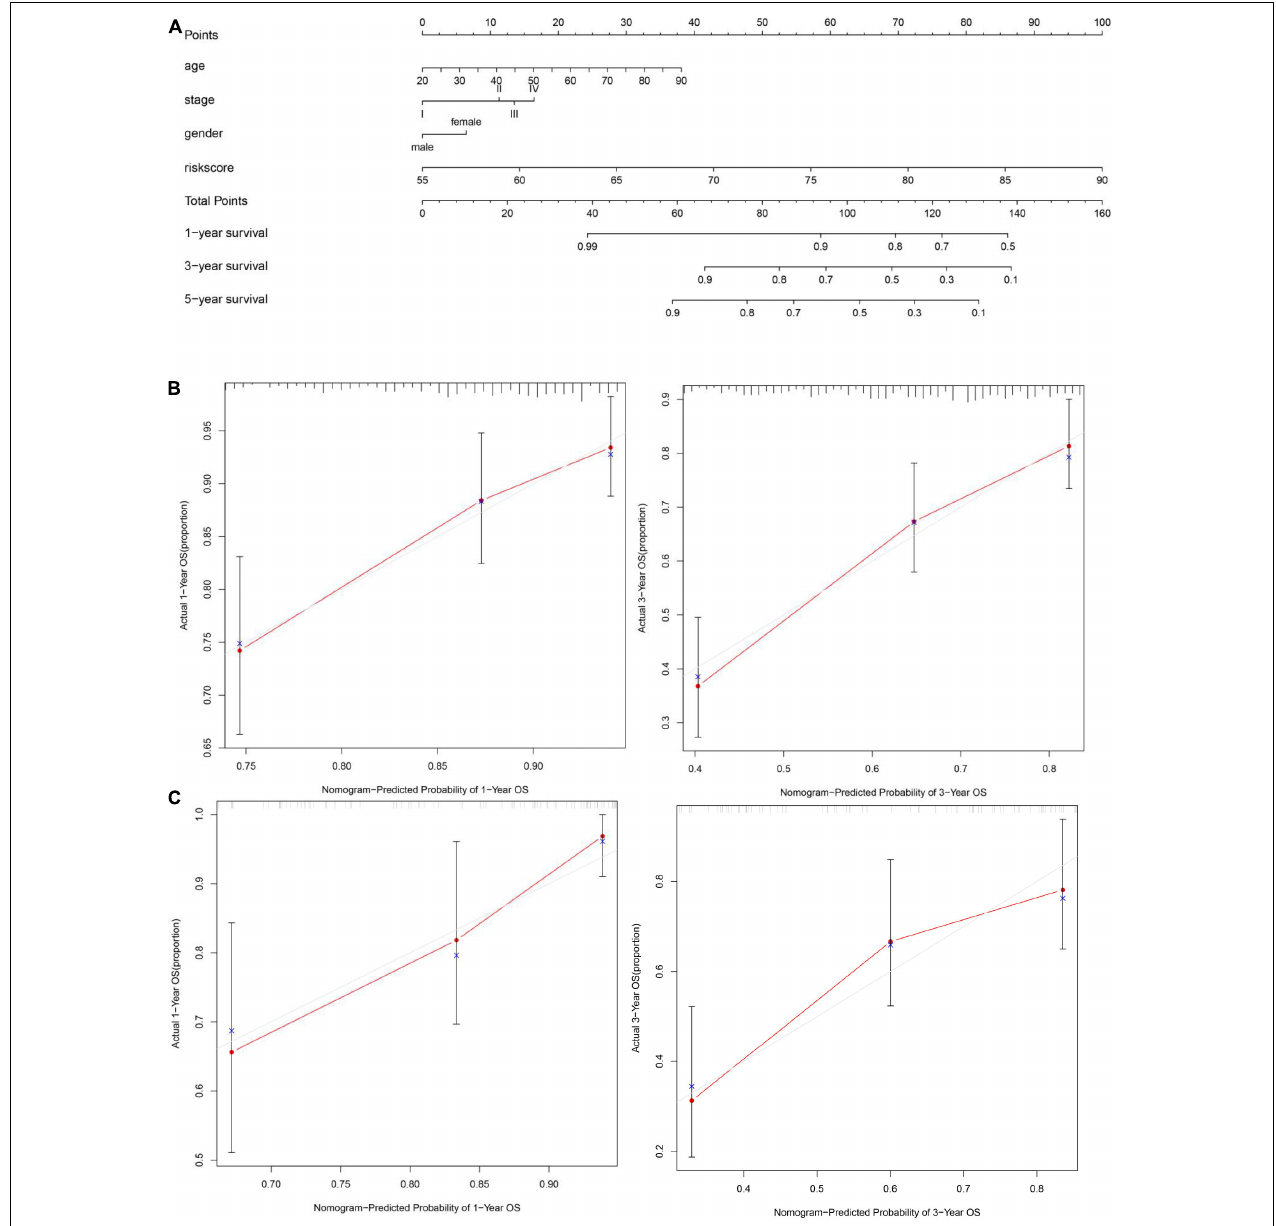
FIGURE 7 | Construction of a nomogram and evaluation patient’s survival rate with HNSCC. (A) A nomogram to predict the 1-, 3-, and 5-year overall survival (OS) of patients with HNSCC was constructed with the TCGA training set ( n = 326). (B) A calibration plot of the nomogram was used to predict the 3- and 5-year OS of the cancer genome atlas (TCGA) training set ( n = 326). (C) A calibration plot of the nomogram was used to predict 1- and 3-year OS in the GSE41613 dataset ( n = 97). The ideal nomogram is represented by the gray line, and the actual nomogram is represented by the red line.